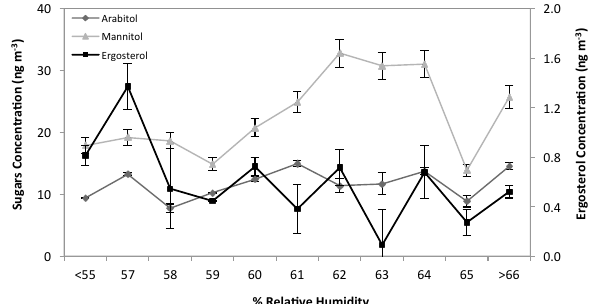
Fig. 6. Correlation between the ambient ergosterol, arabitol and mannitol concentrations with average relative humidity at the sam- pling site. Ergosterol shows high levels at low %RH while mannitol levels rise when average %RH between 62–65%. Arabitol does not show a distinct relationship with the relative humidity.